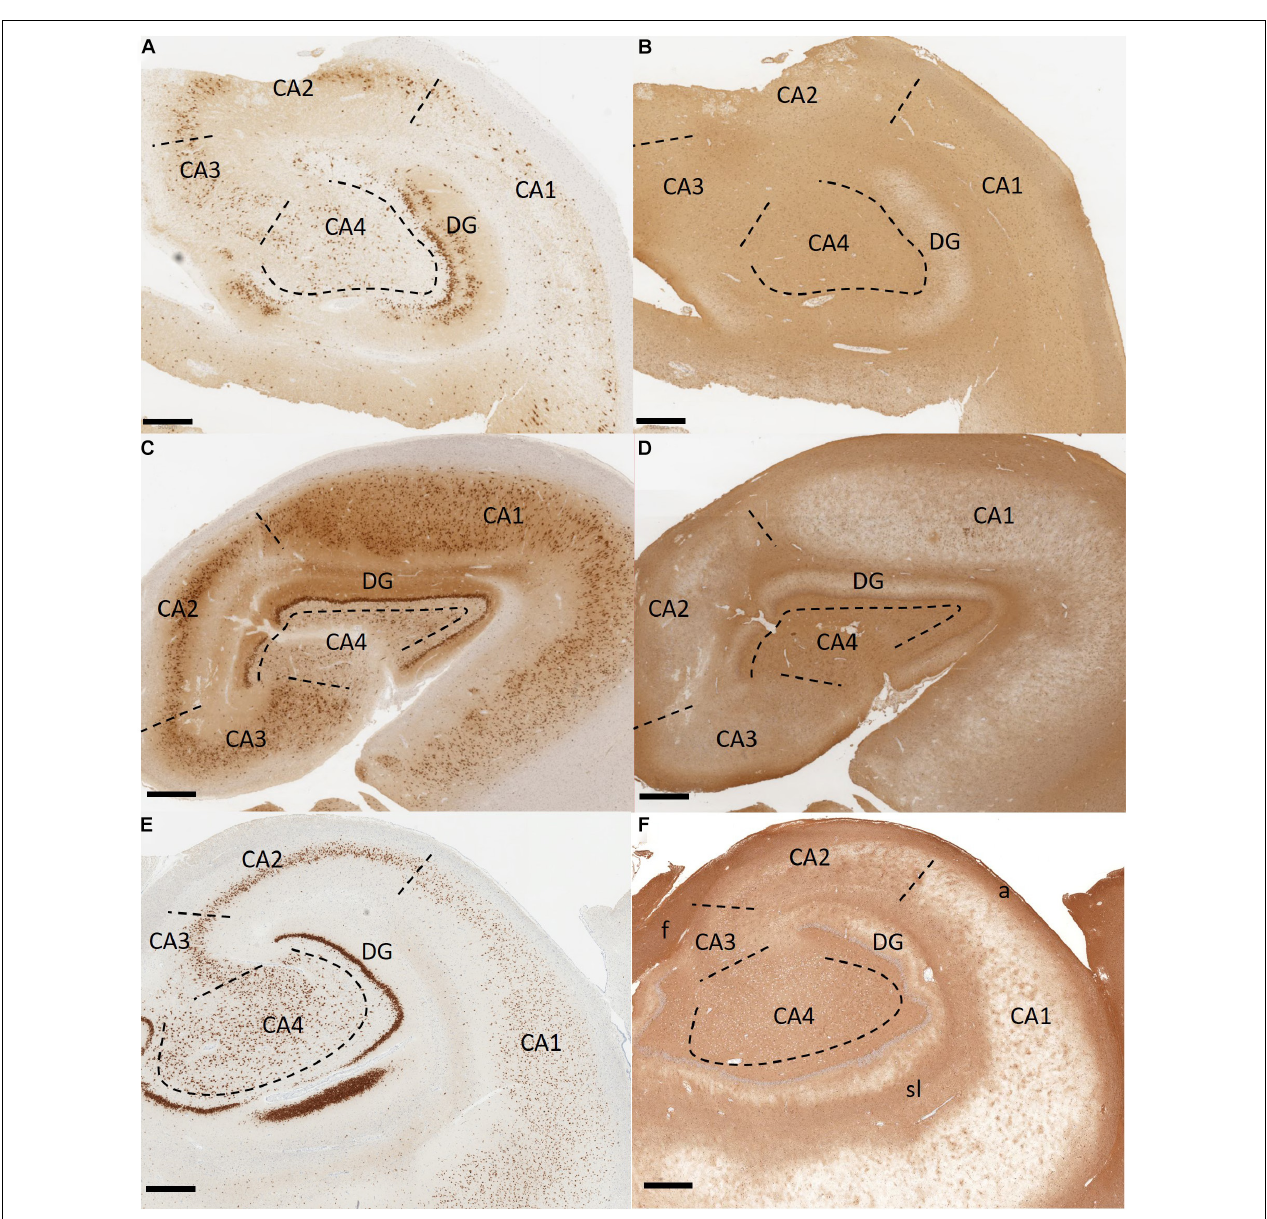
FIGURE 3 | Immunohistochemistry stained histological sections of hippocampus tissue resected from patients with temporal lobe epilepsy. (A,B) An example of hippocampal sclerosis Type 1. There is significant pyramidal neuronal loss in CA1 and CA4. CA3 and dentate gyrus also show moderate to severe neuronal loss. Dentate granule cell dispersion and bilamination (“tram-tracking”) are also present (A) . There is diffuse reactive gliosis (B) . (C,D) Hippocampal sclerosis Type 4 (no-HS). There is no significant neuronal loss in the CA sectors (C) . Gliosis, more prominent in the CA4, is present (D) . (E,F) Non-epileptic hippocampus from an autopsy case. The CA sectors are well populated with neurons. Strong positive GFAP staining is localized in the white matter (alveus, fimbria, and striatum lacunosum). Non-specific staining is also noted in CA4 and CA3. Immunohistochemistry with antibodies to NeuN in (A,C,E) and GFAP in (B,D,F) . Scale bar 500 µ m. (CA, Cornu ammonis; DG, dentate gyrus; a, alveus; f, fimbria; sl, striatum lacunosum. Department of Pathology and Laboratory Medicine, London Health Sciences Centre, University Hospital, London, ON,